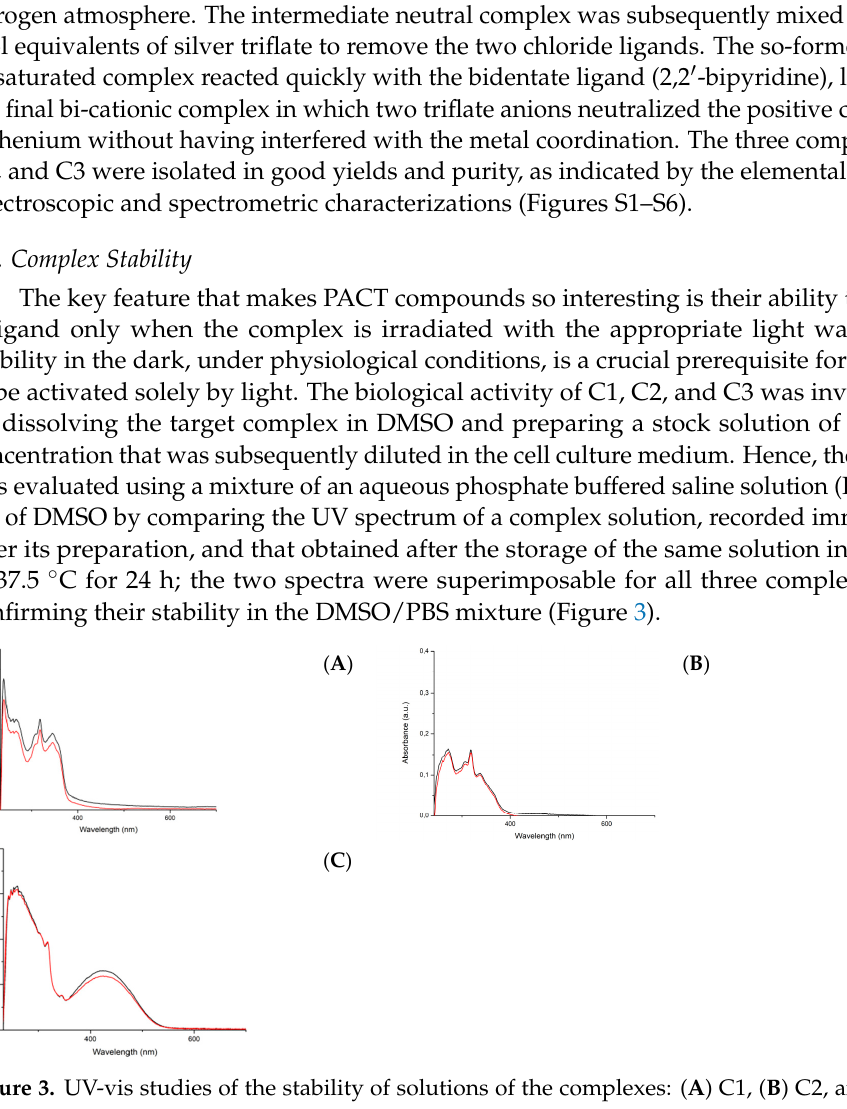
Figure 3. UV-vis studies of the stability of solutions of the complexes: ( A ) C1, ( B ) C2, and ( C ) C3, all 20 µ M. Comparison between time-zero solution (black line) with the same solution after 24 h of incubation at 37.5 °C in the dark (red line).2.3. Absorption and Emission Spectra of the Ru(II) Complexes